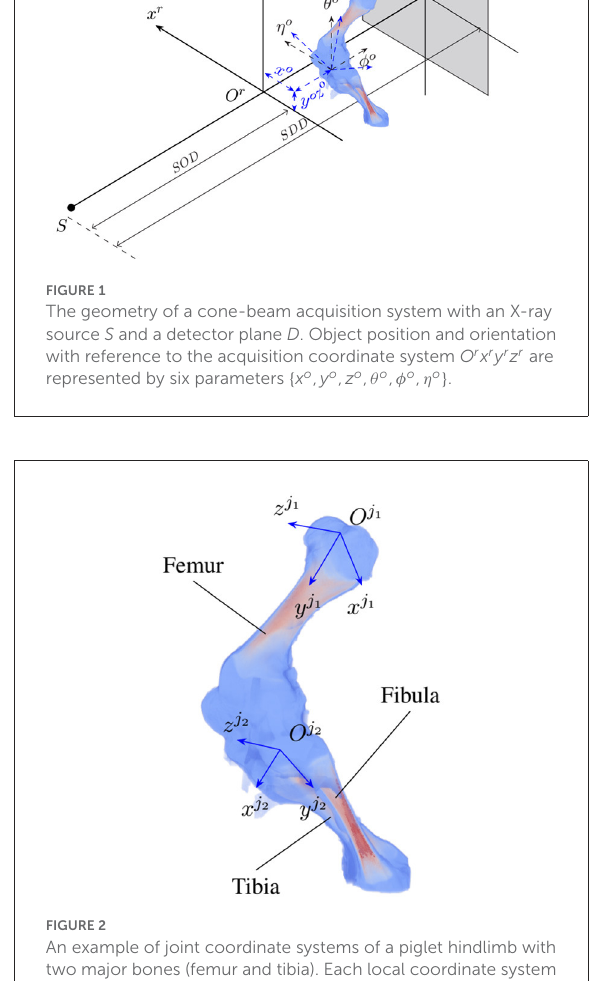
to avoid redundancy in the pose reconstruction. In total, 5 +